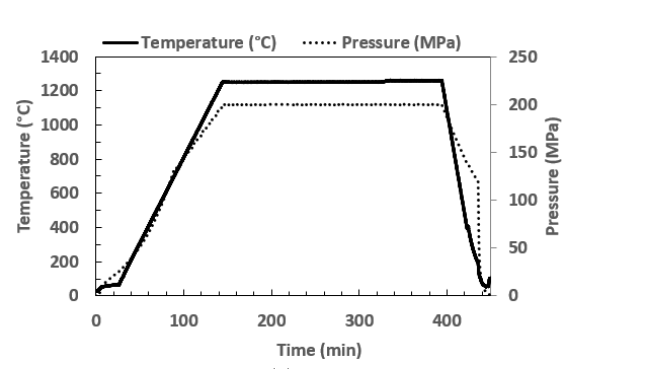
Figure 4. HIP; ( a ) Quintus-QIH9 model and ( b ) URQ ® technology. Figure 5 plots the temperature-time-pressure profile (T-t-P) for the sample TNM-1.5B-IHT, in which a precise and fast cooling rate was obtained, due to the quenching module of the IHT unit.